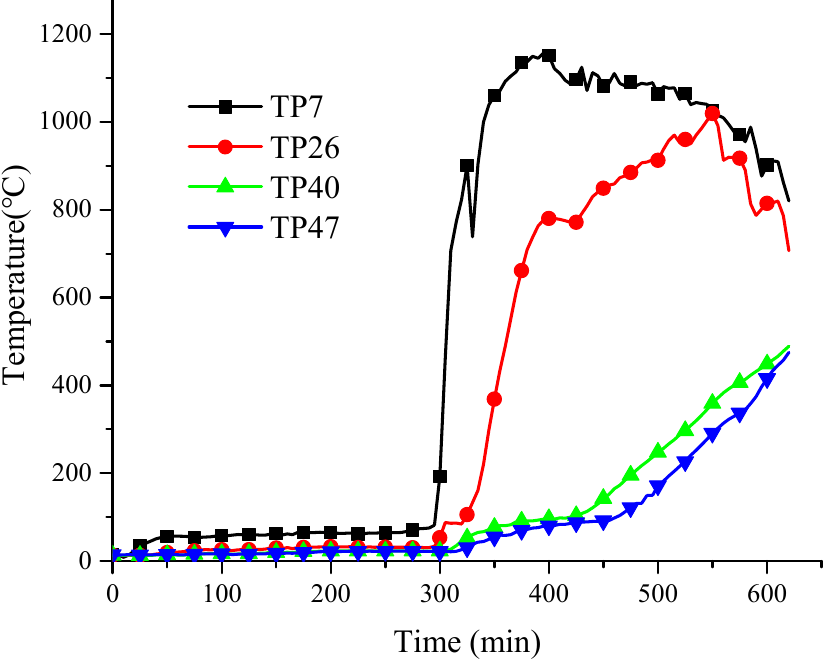
Figure 9. Temperature variation curves at different positions in vertical direction.